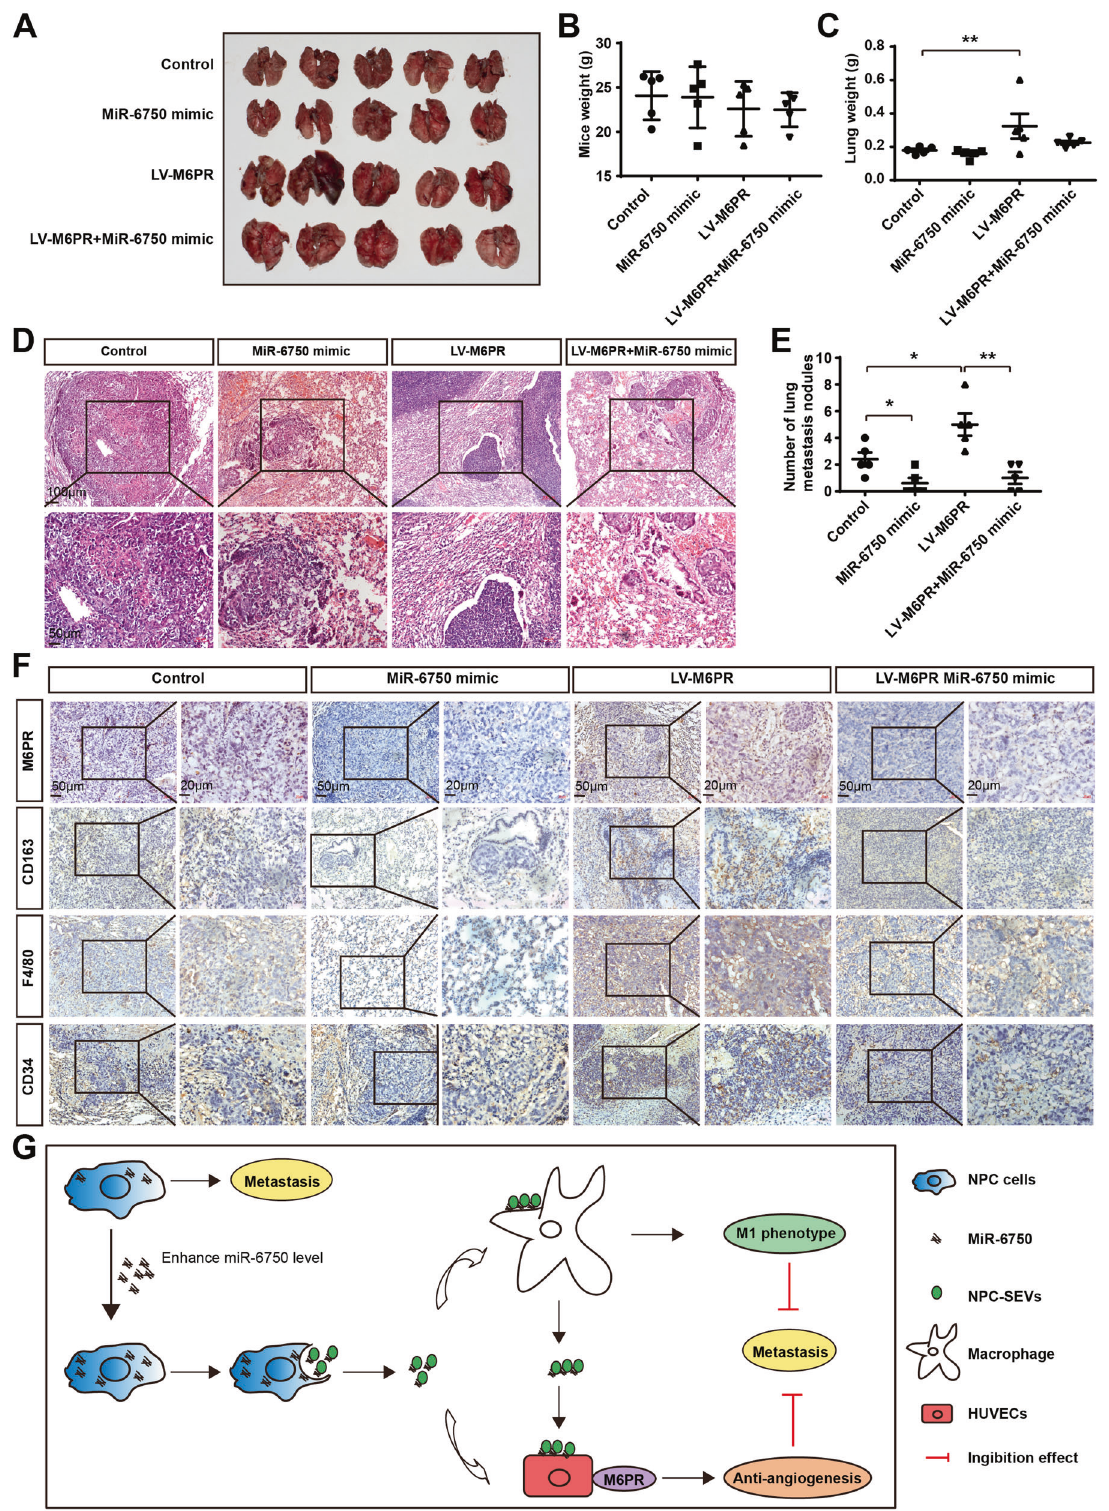
Fig. 8 MiR-6750 directly targets M6PR to regulate NPC metastasis. A Gross-observation lung metastasis in graph-depicted groups. B , C Statistical analyses of mice weight and lung weight. Student ’ s t-test. D Representative images of HE staining. E Statistical analyses of Number of lung metastasis nodules in graph-depicted groups. Student ’ s t-test. F Representative images of M6PR, CD163, F4/80, and CD34 in tissues collected from graph-depicted groups. G Schematic diagram of the mechanism for miR-6750-M6PR axis inhibiting metastasis by establishing an anti-metastasis microenvironment.